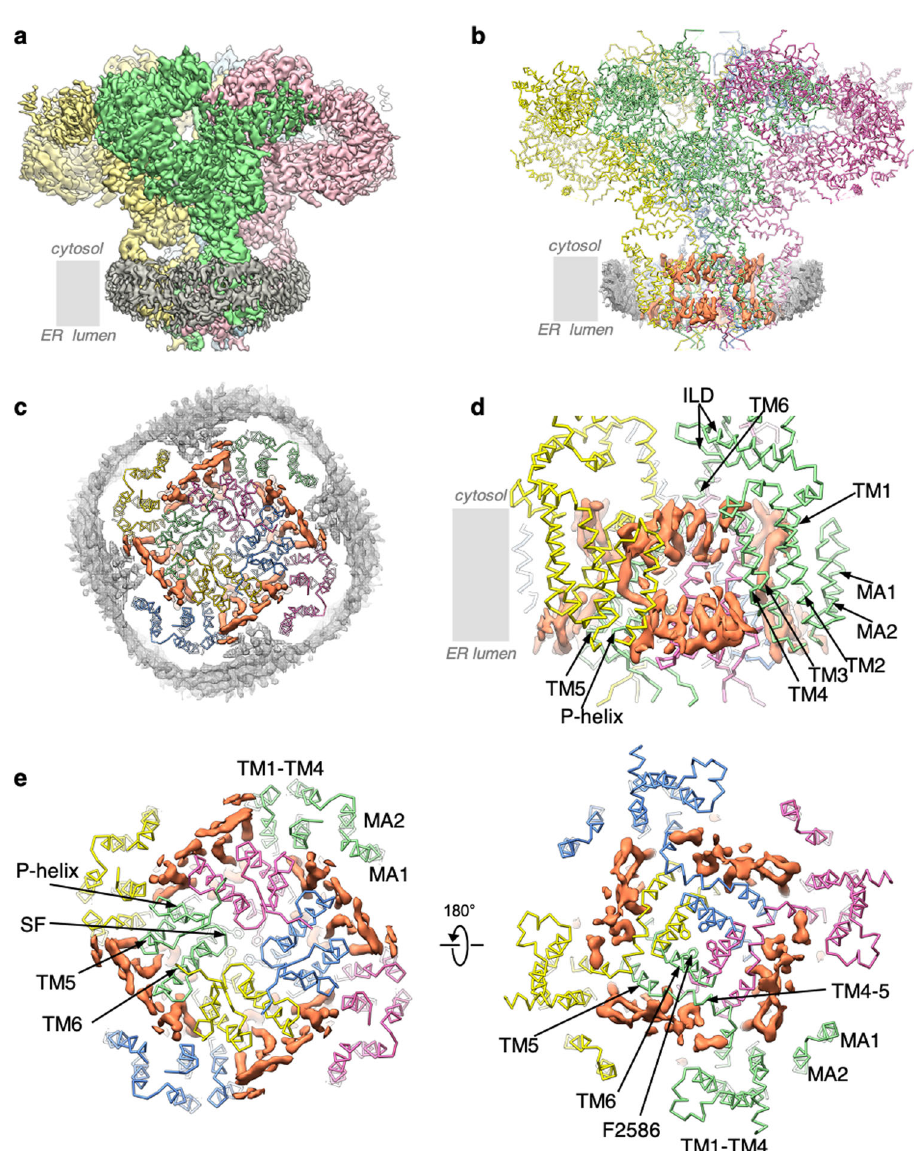
Fig. 1 Overview of lipids in the IP 3 R1-ND structure. a The cryo-EM density map of the IP 3 R1-ND complex is viewed along the membrane plane. Subunits are color-coded and lipid-nanodisc densities are colored gray. b The atomic model of IP 3 R1-ND viewed along the membrane plane. A slice through the nanodisc densities (gray mesh) reveals the protein-bound lipid densities (orange). The model of IP 3 R1 is shown in wire representation and color-coded by subunit. c TM region of IP 3 R1 in nanodiscs viewed from the lumen along the channel ’ s four-fold symmetry axis. d TM region viewed along the membrane plane; the lipid densities are shown in orange and displayed at 5 σ threshold. e Zoomed-in view of lipid densities in inter- and intra-subunit crevices viewed along the four-fold axis from the lumen (left) and cytosol (right). The side-chain of F2586 that constitutes the gate in TM6 is